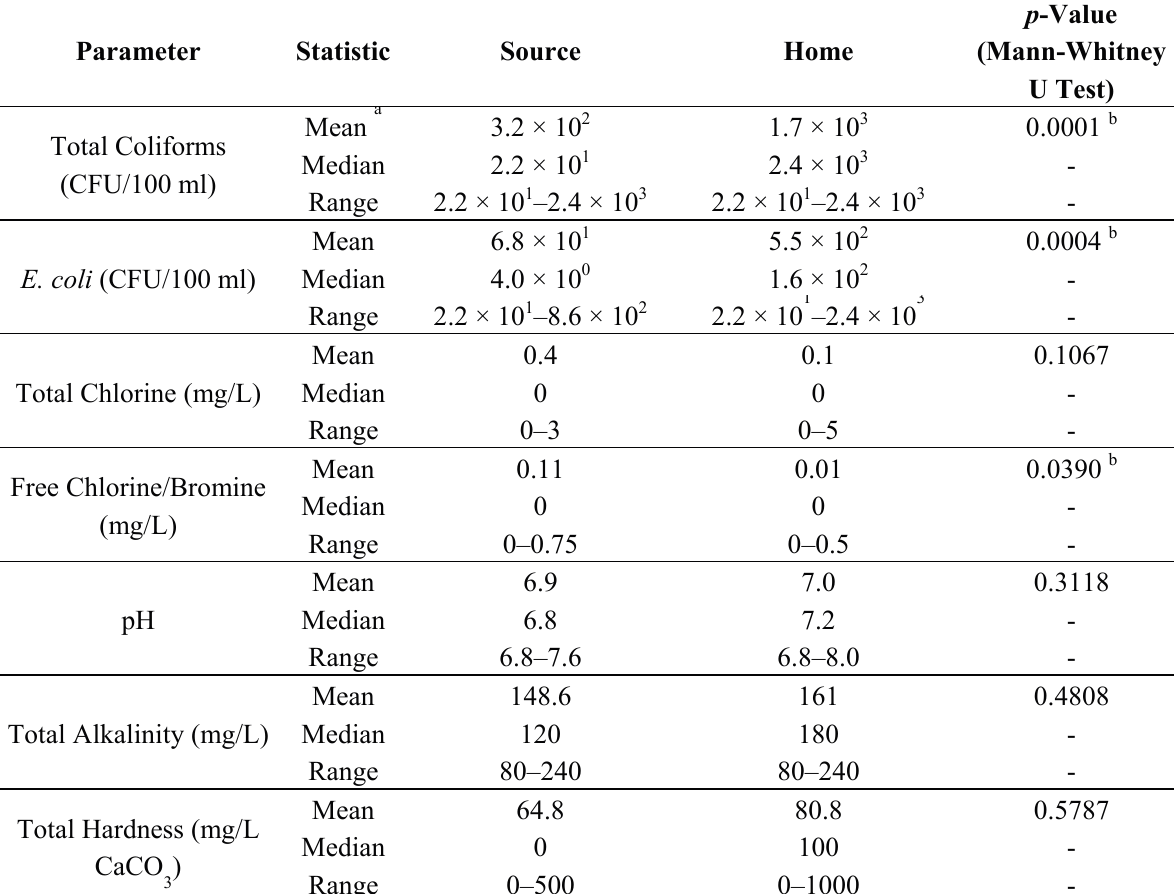
Table 3. Comparison of water quality from the water samples collected at drinking water sources and homes (source, n = 25; home, n =